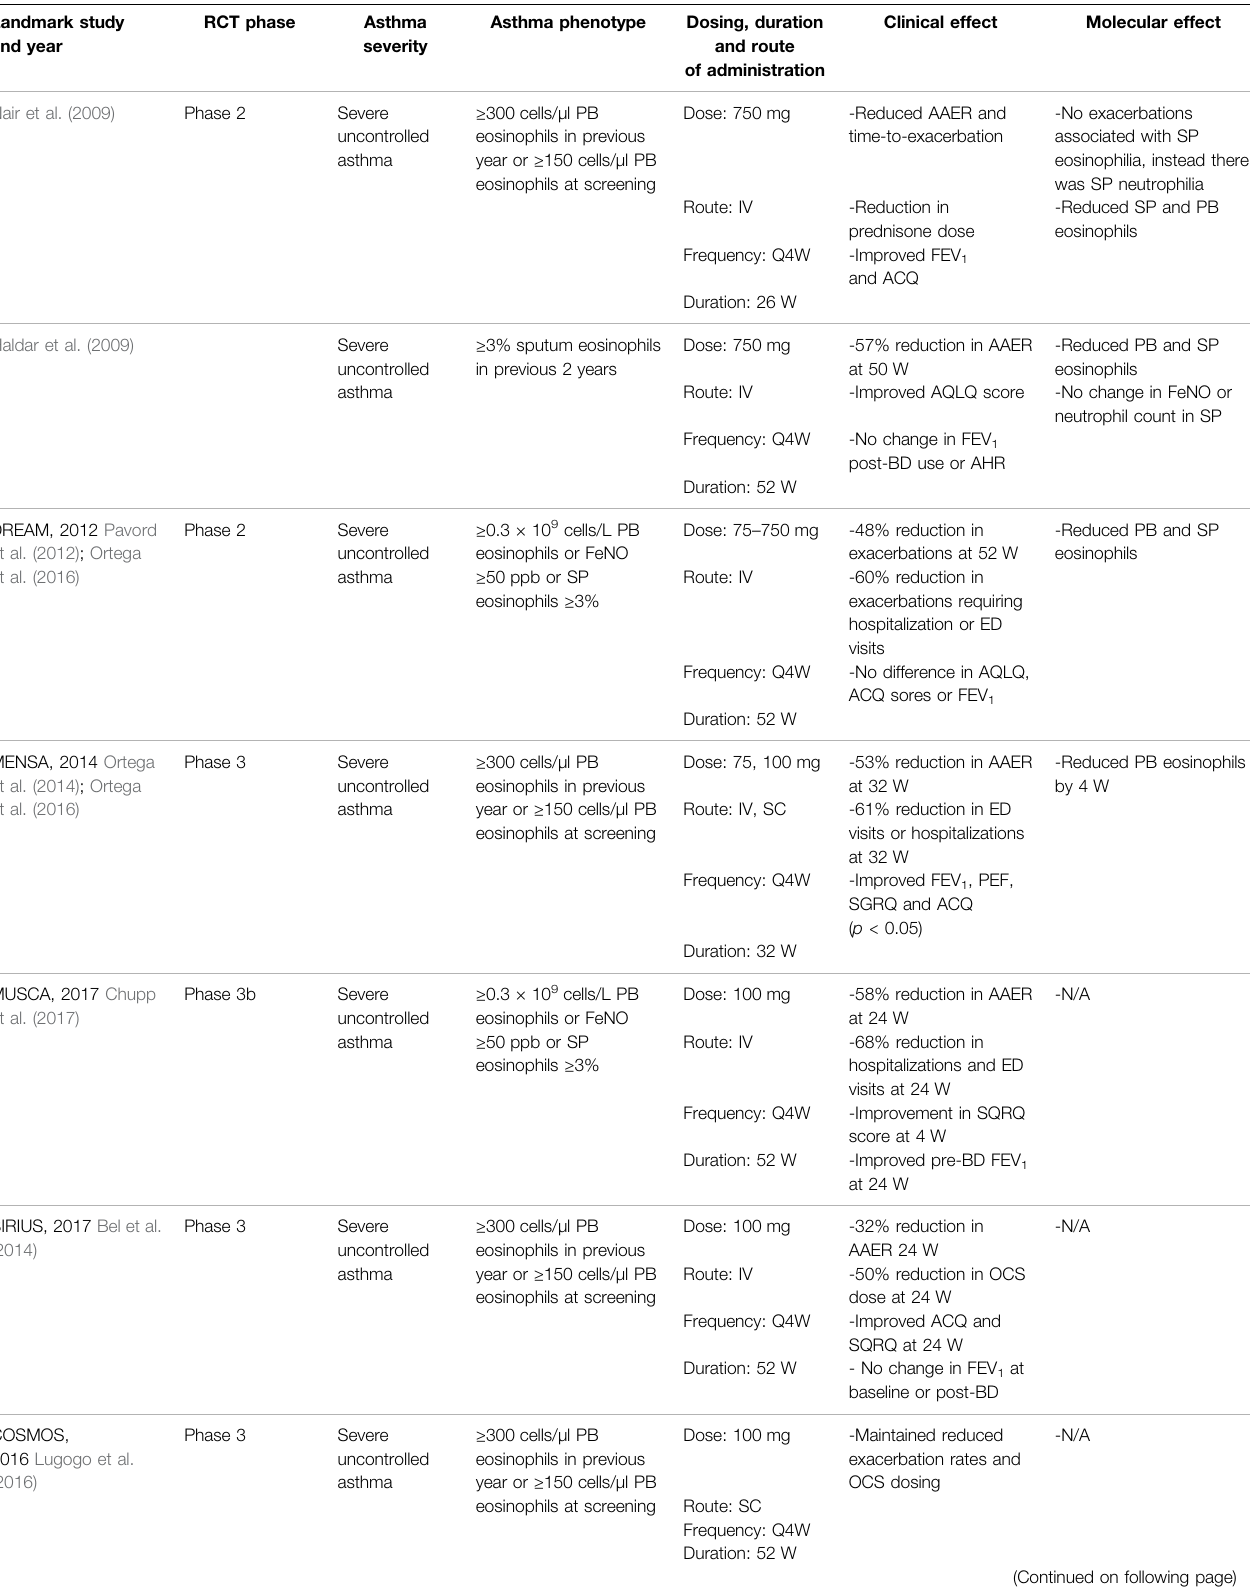
TABLE 2 | Summary of randomized clinical trials assessing mepolizumab in severe